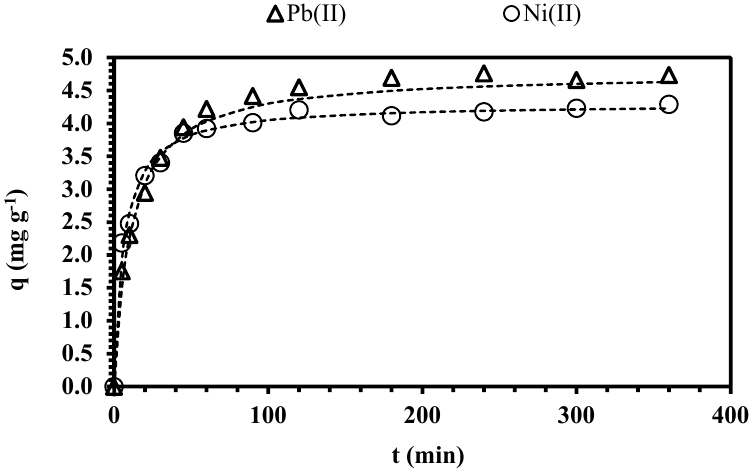
Figure 5. Effect of contact time on CAM-D2EHPA dried beads. (Dashed line: Pseudo-second order model (PSORE) model; T : 20 ◦ C; V : 0.01 L; m : 0.1 g; agitation speed: 180 rpm; contact time: 3 h; pH: 4; C 0 : 50 mg L − 1 , 0.005 M NaNO 3 ).